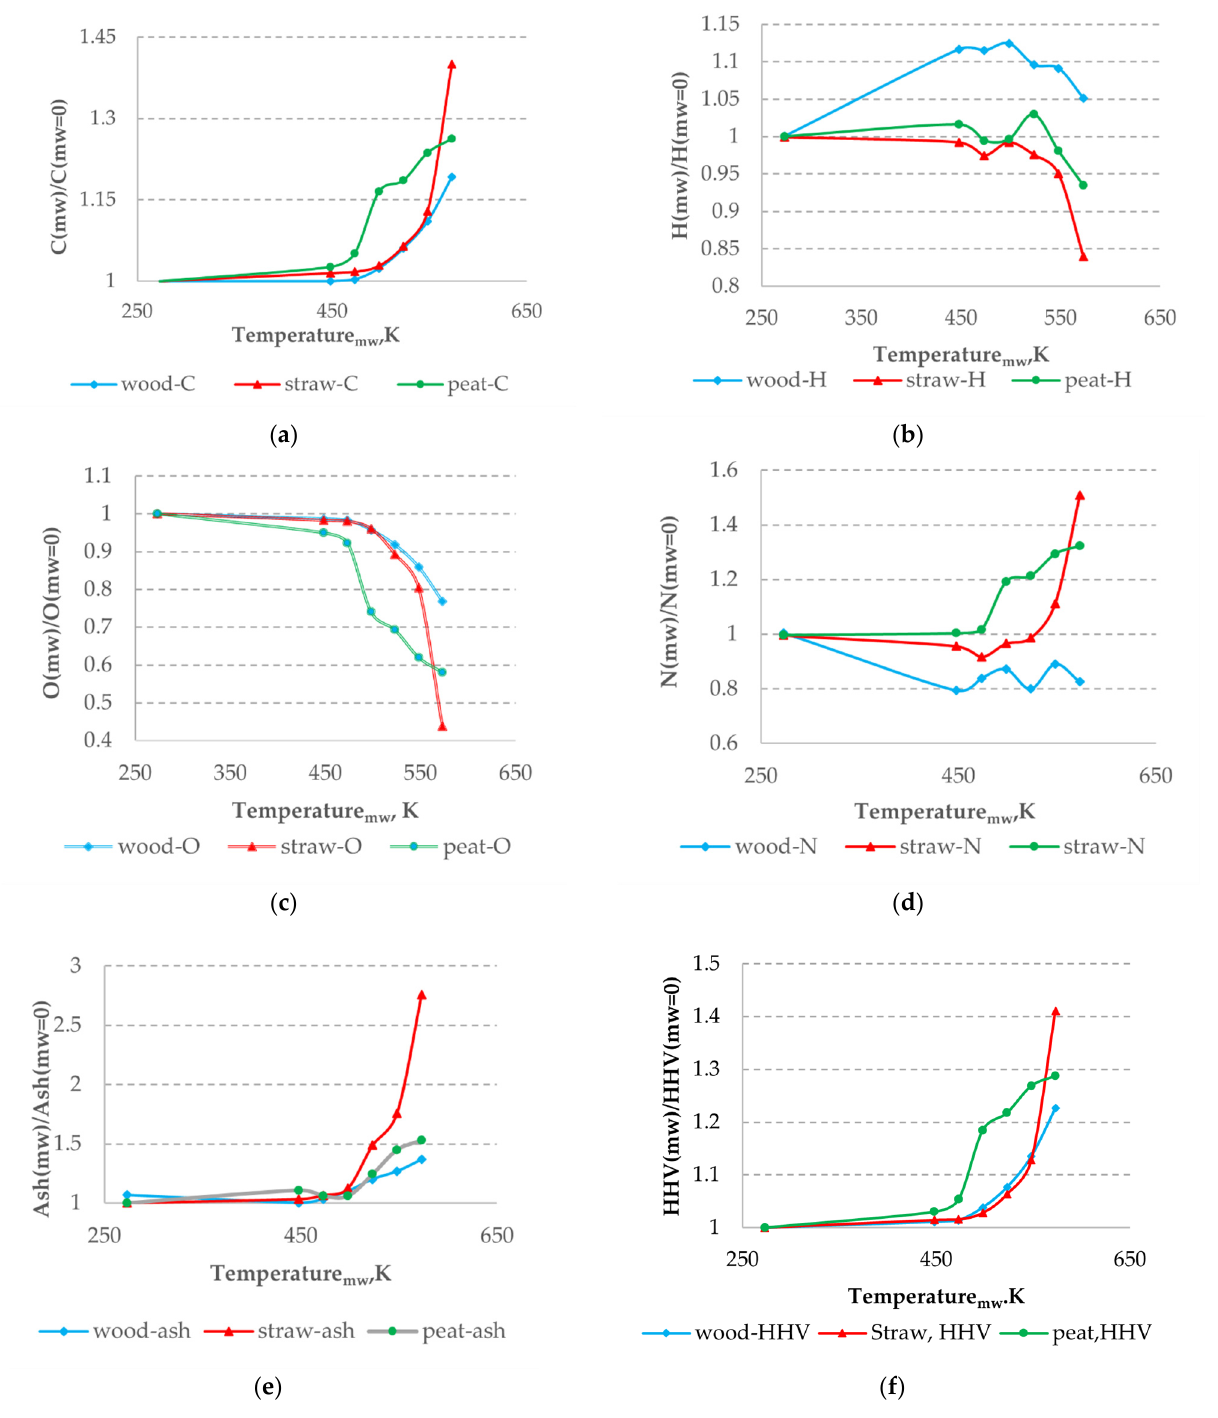
Figure 3. The effect of increasing the temperature of mw pretreatment of wood, wheat straw and peat pellets on the relative changes of carbon ( a ), hydrogen ( b ), oxygen ( c ), nitrogen ( d ), and ash ( e ) contents and higher heating value ( f ) of pre-treated pellets.